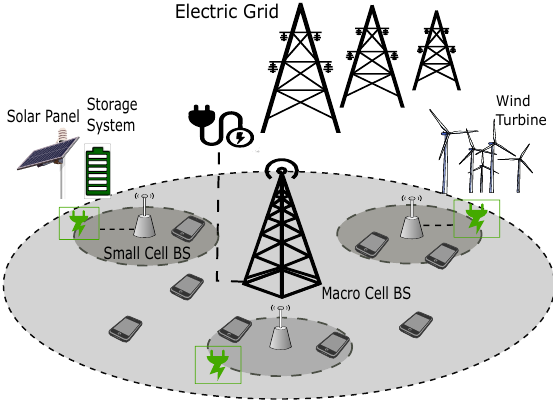
Figure 1. Scheme of a hybrid-energy heterogeneous cellular